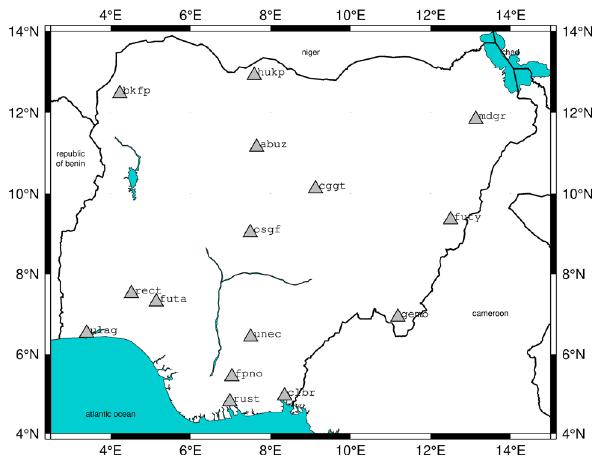
Figure 1. Map of Nigeria depicting the GNSS stations used for the study (Bawa et al.,